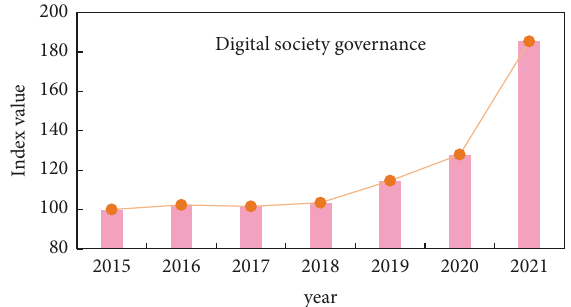
Figure 9: Digital society governance evaluation results.